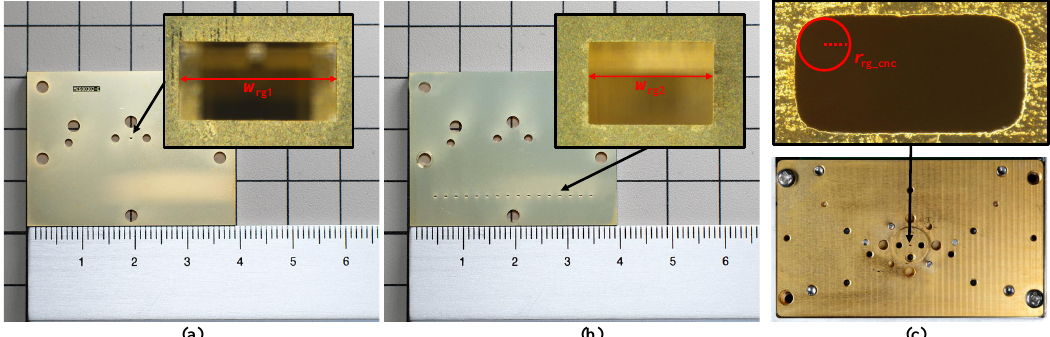
Figure 13. ( a ) The input port of the fabricated 16-way power divider. ( b ) The output ports of the fabricated 16-way power divider. ( c ) The input port of the fabricated metal